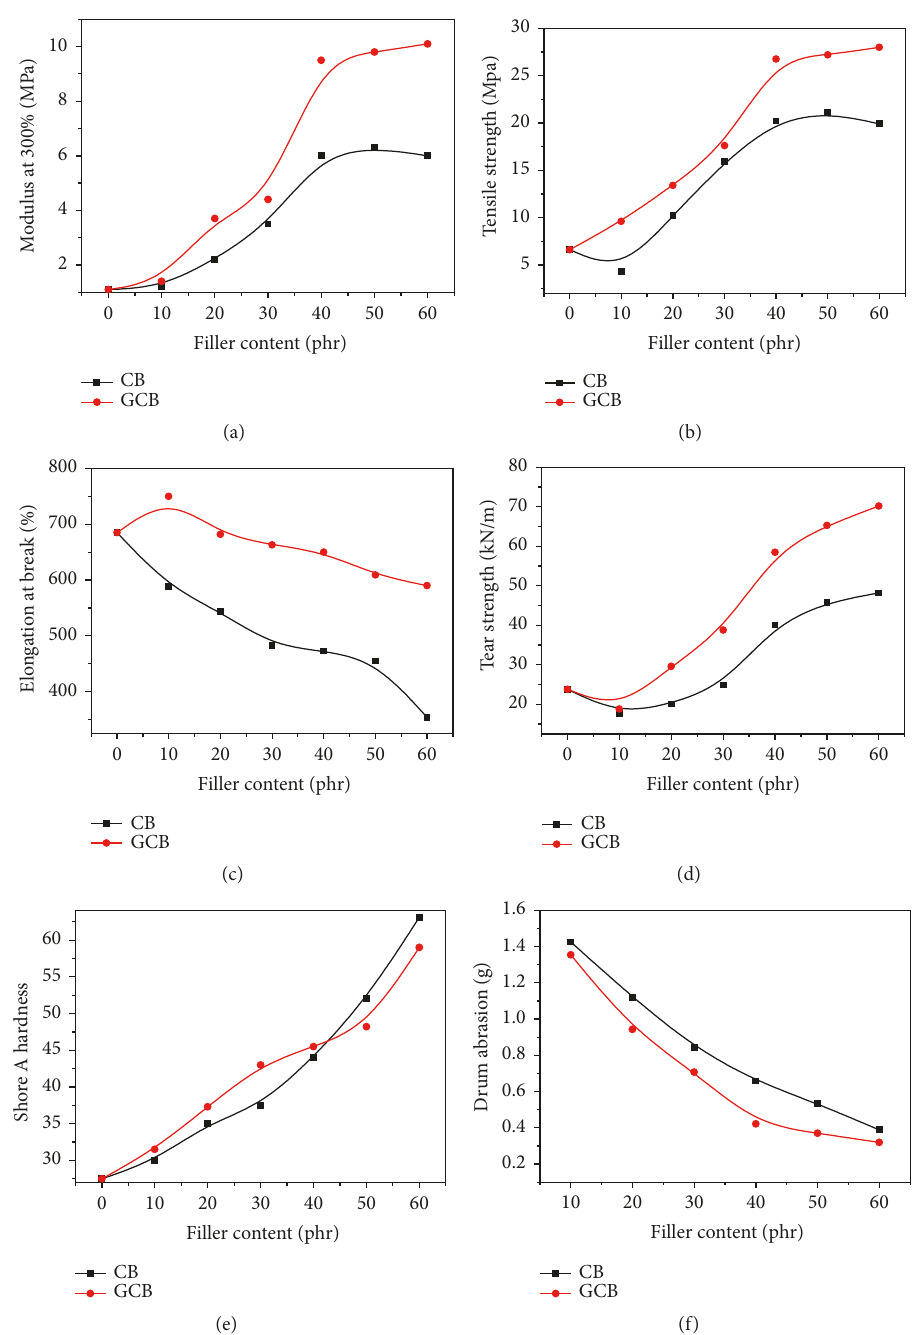
Figure 2: Physical and mechanical properties of NR/CB and